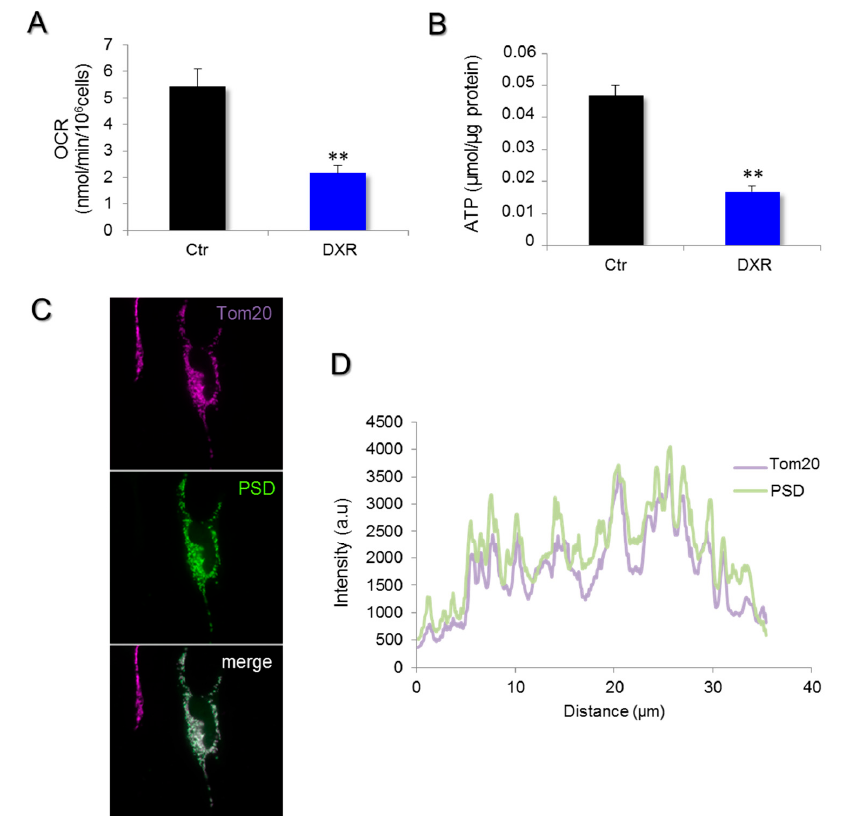
Figure 3. Doxorubicin inhibits mitochondrial respiration and reduces ATP content. ( A ) Mitochondrial respiration was measured in HeLa cells treated for 6 h with 5 µM DXR, and the endogenous rate of respiration was recorded. Data are expressed as mean values of oxygen consumption rates (OCRs) ± SEM, N = 5 experiments with P = 0.006 (**, P < 0.01). ( B ) The total ATP content of HeLa was determined by bioluminescence in cells treated or untreated with 5 µM doxorubicin for 24 h. The results are expressed in µmol/µg protein as mean values ± SEM. The difference was considered as significant when P < 0.05 (**, P < 0.01). ( C ) The PSD subcellular repartition was investigated by immunofluorescence on HeLa cells. Cells were transfected for 48 h with pCMV6-PSD-DDK-myc plasmids and were then fixed with PFA 4%. After cell permeabilization by triton 15%, PSD was labeled with the anti-DDK antibody and the secondary antibody AF-488 anti-mouse (green). Immunostaining of the mitochondrial network (far red) was obtained with an anti-TOM20 antibody and a secondary one, AF-647 anti-rabbit. ( D ) The fluorescence intensity was measured and illustrated with the line-scan to show the overlaps between Tom20 (far red) and PSD expression (green). We verified the localization of PSD within HeLa cells using a tagged version of this enzyme. The immunocytochemistry images revealed a mitochondrial expression of PSD (Figure 3C,D). The co- localization quantification of the enzyme with Tom20, a mitochondrial protein, was estimated with the Pearson index (0.93 ± 0.04, N = 22) that was in accordance with an expression within the mitochondrial compartment.